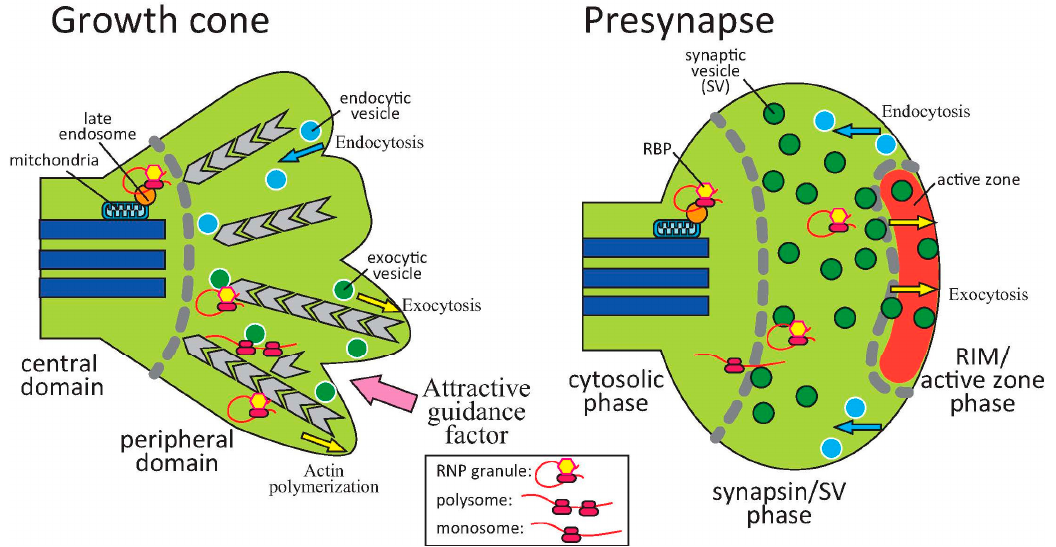
Figure 2. Sites of local translation in growth cones and presynapses. Growth cones are composed of two domains: central domains and peripheral domains. Late endosomes in proximity to mitochondria serve as platforms to bind RNP granules for local translation, which also occurs in the central domain of growth cones. In response to attractive guidance factors, RNP granules localize on the stimulated side, followed by local translation. Presynapses are separated into three phases by phase separation: cytosolic, synapsin/synaptic vesicle (SV), and Rab3-interacting molecule (RIM)/active zone phases. RNP granules (FMRP-containing granules) often localize at the synapsin/SV phase. Ribosomes are sometimes at the synapsin/SV phase; however, they are offset from the active zone.